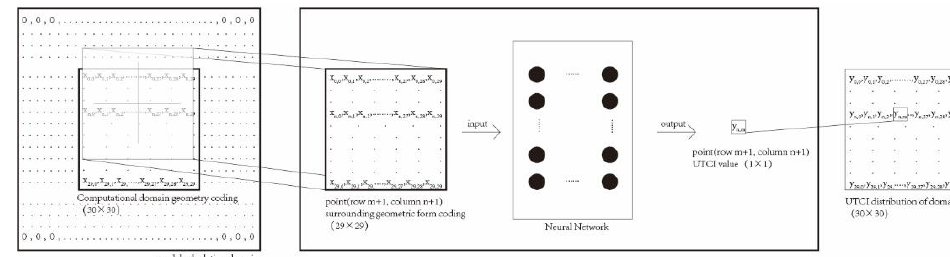
Figure 5. Schematic diagram of Group A.